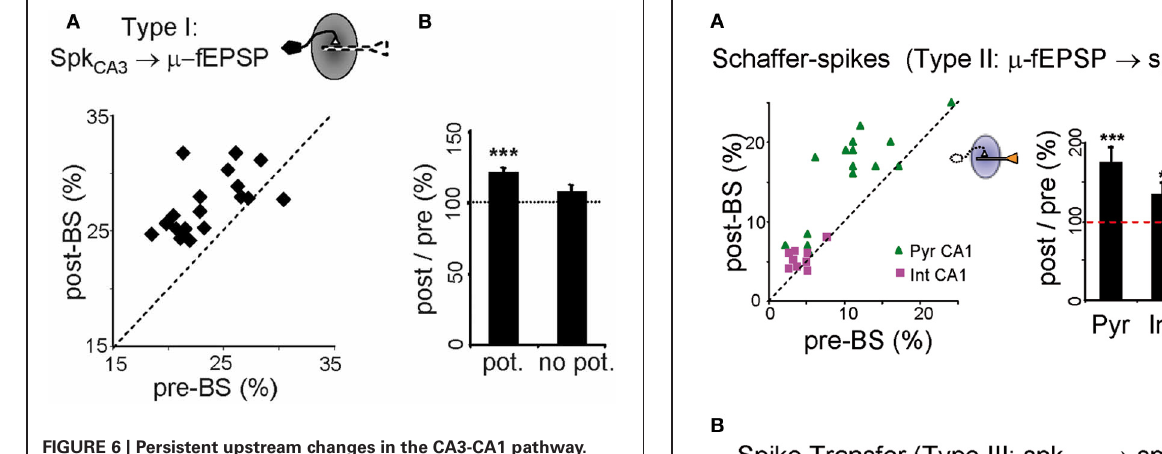
FIGURE 6 | Persistent upstream changes in the CA3-CA1 pathway. (A) Correlation between percentage of spikes of potentiated CA3 pyramidal cells monosynaptically related to μ -fEPSPs (Type I relationship) before and after BS. Note that the values fall above the midline. (B) Only those CA3 pyramidal cells exhibiting potentiated spike-triggered averages in CA1 ( pot .) increase the post/pre BS in-cluster presynaptic firing. Data obtained from 10-min epochs taken before and 1h after BS (mean ± sem, n = 6 animals; ∗∗∗ p < 0 . 001, Student’s paired t -test).